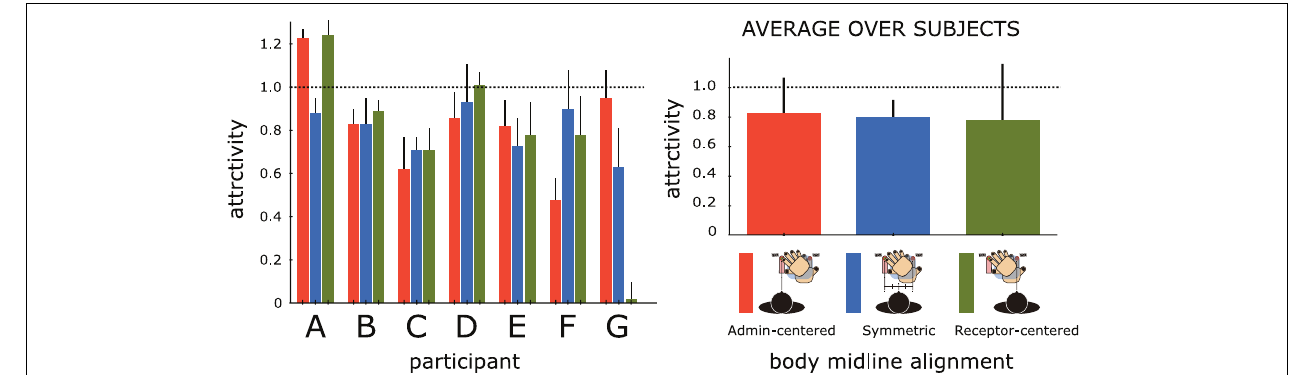
FIGURE 8 | Results of the average attractivity of seven “illusion-sensitive” participants for three types of body midline alignments in Experiment II. Three colors depict where the body midline is aligned in the session; it is aligned with the administrating (right) hand in the Admin-centered condition, with the